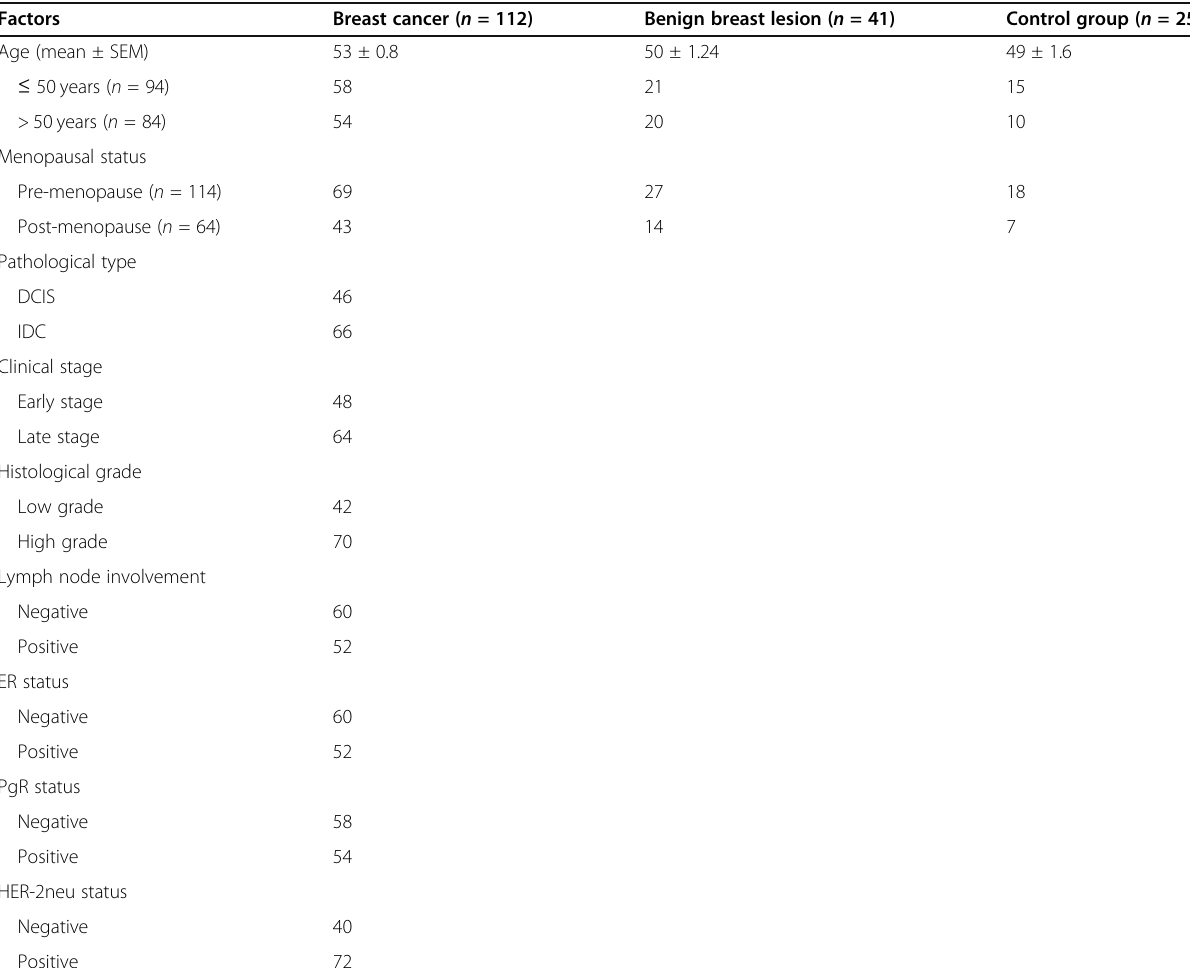
Table 1 Clinical and demographic characters for enrolled patients